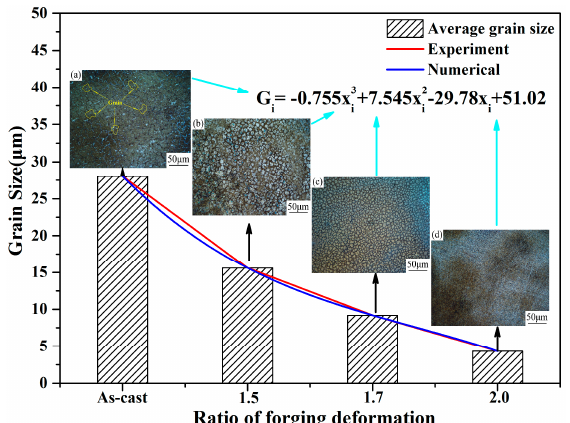
Figure 3. Grain size of 0.4C-Si-Mn-Cr steel with different H/D values for the deformation process. ( a ) As-cast, ( b ) H/D = 1.5, ( c ) H/D = 1.7, and ( d ) H/D = 2.0.